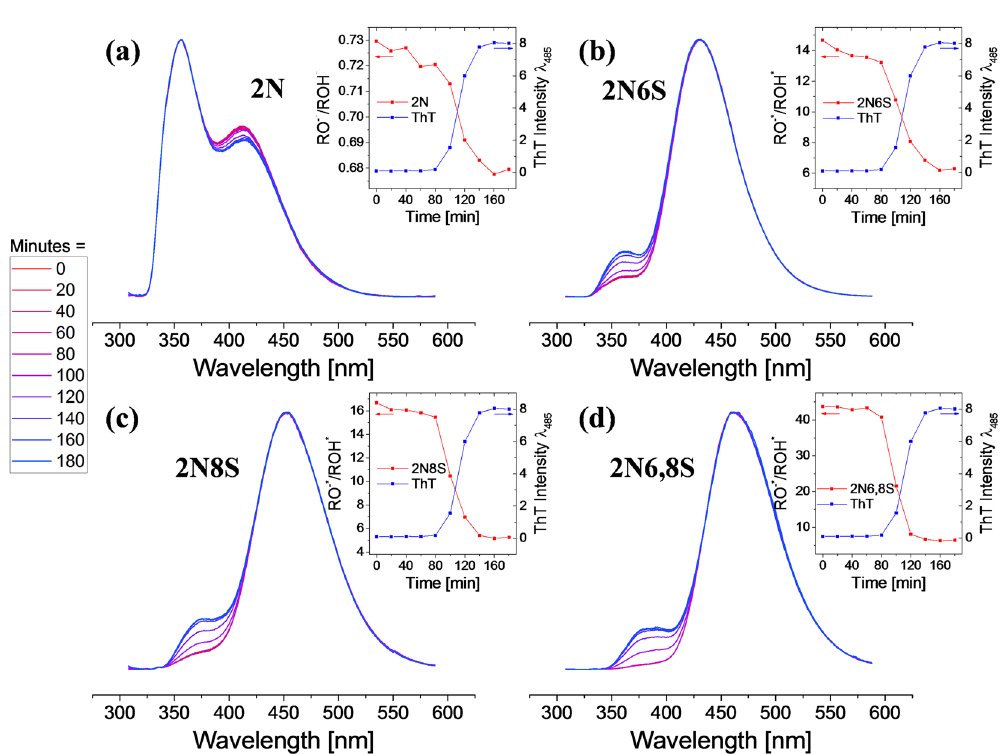
Figure 8. Normalized steady-state fluorescence of the different photoacids: ( a ) 2N, ( b ) 2N6S, ( c ) 2N8S and ( d ) 2N6,8S during the amyloidogenesis process at 20 min intervals from 0 min (red) to 180 min (blue), together with kinetics traces (inset) comparing the RO − * /ROH * ratio of the photoacid with ThT emission as a function of